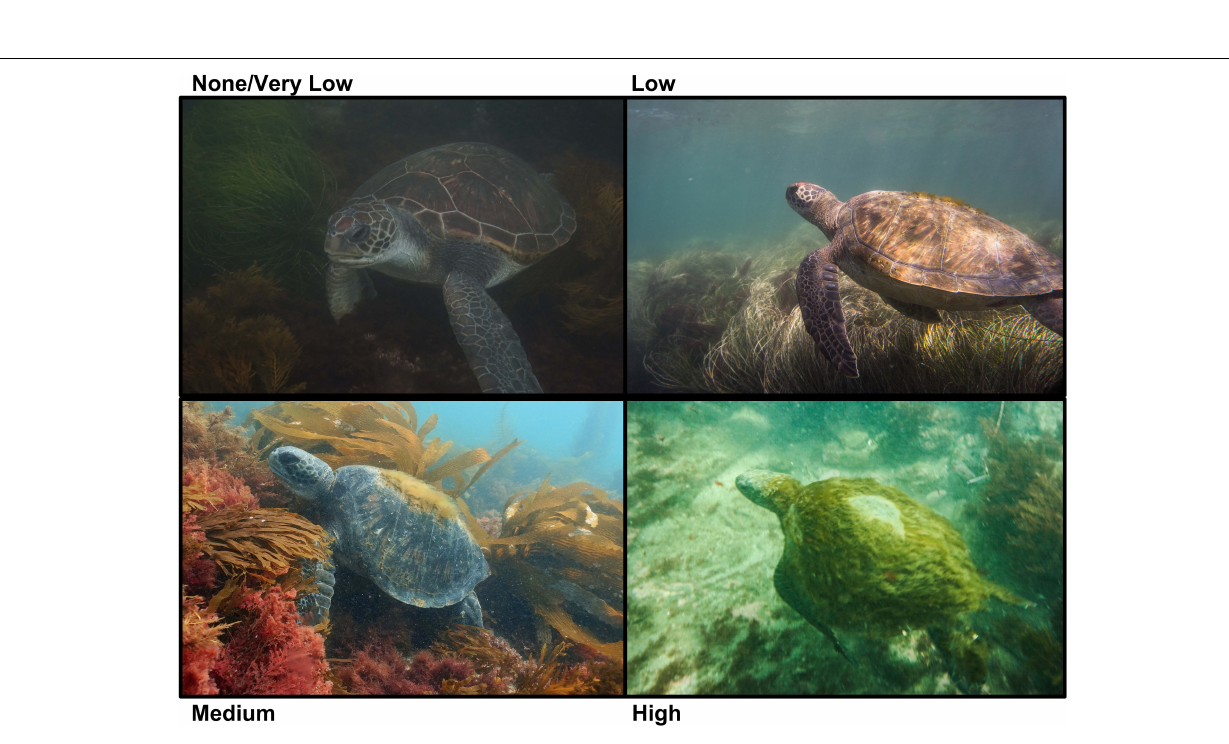
Frontiers in Marine Science |